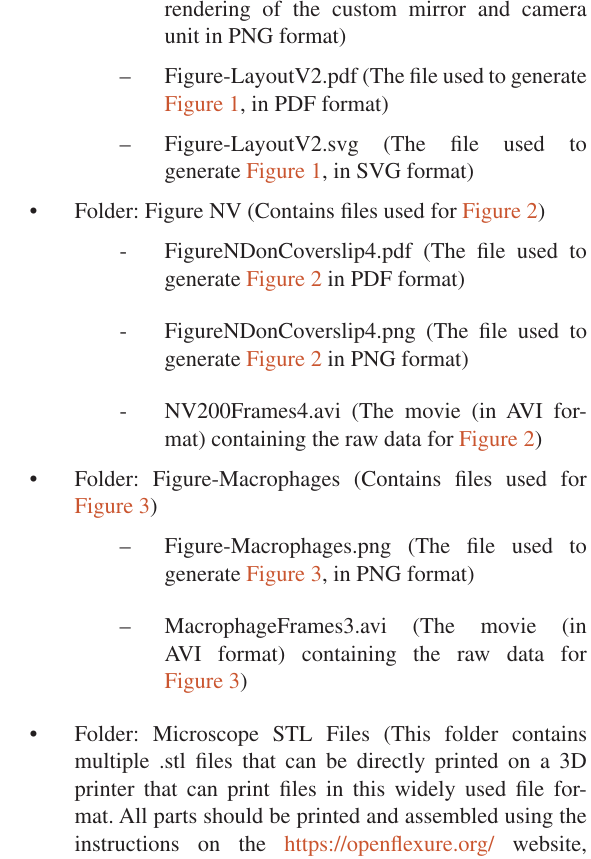
Figure 3. Fluorescence imaging of 90 nm nanodiamond in monocyte-derived